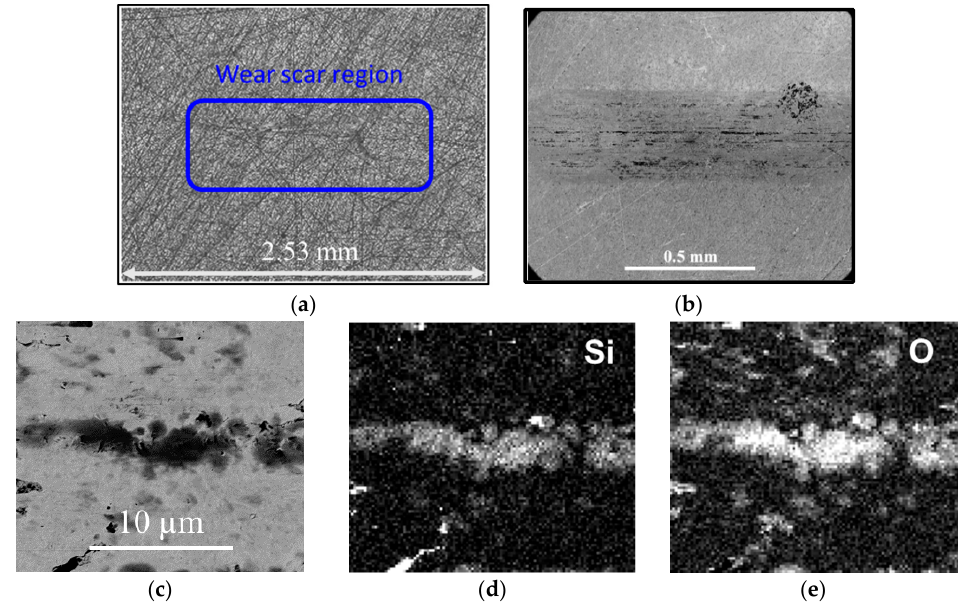
Figure 4. Disc surface after tribotesting at V{150 N/40–100 °C/80 min}, seen from ( a ) optical profilometer; and ( b ) SEM. ( a ) the roughness inside wear scar can be seen to be of the same order of magnitude as the original lapped surface; ( b ) dark patches in the wear track indicate tribofilm; ( c ) SEM (scanning electron microscopy) image of a representative area of tribofilm at 5000x magnification; ( d , e ) EDS (energy dispersive X-ray spectroscopy) maps showing the distribution of the elements in the area shown in ( c ).